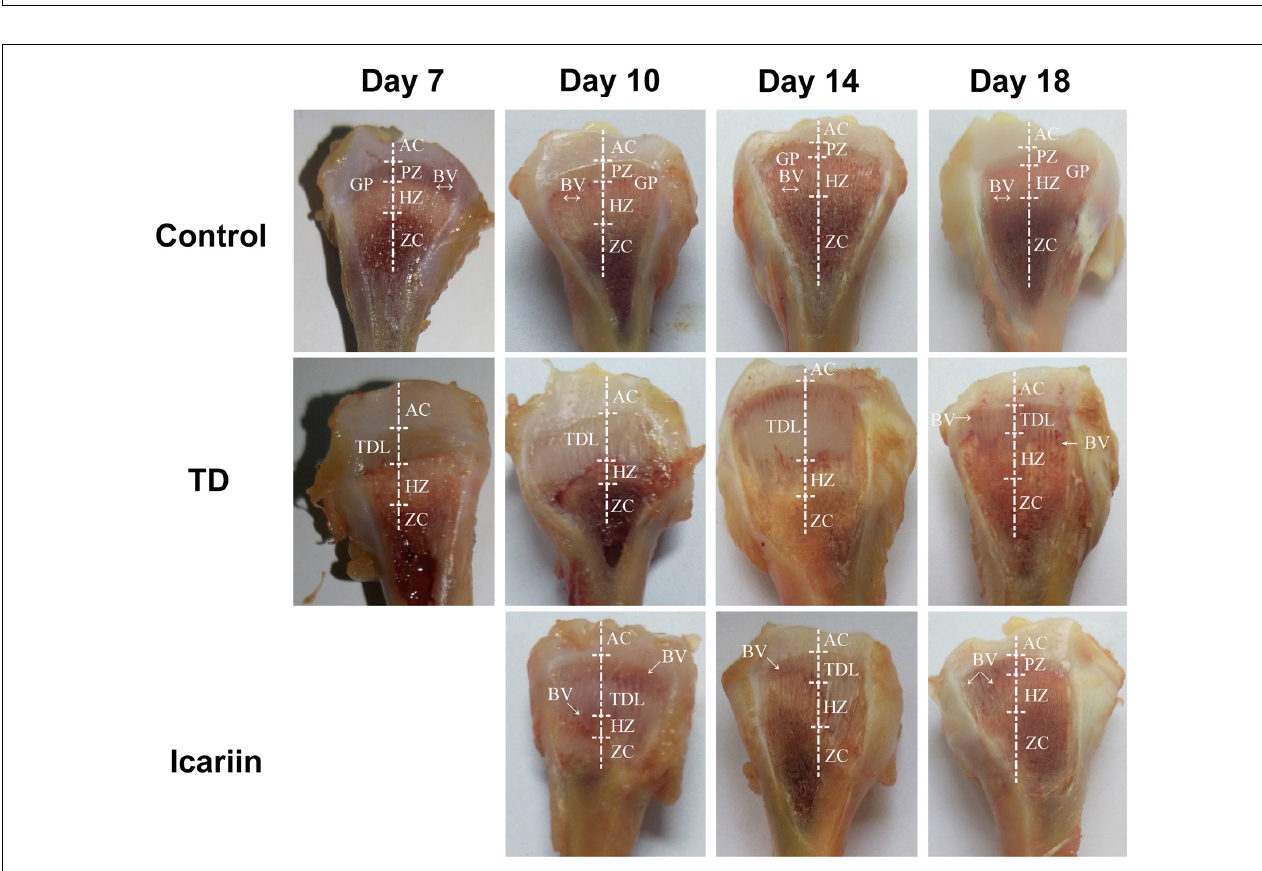
FIGURE 5 | The Morphological analysis of growth plates of control, TD, and icariin-treated chickens during the experiment from days 7 to 18. Extended GP was compared in TD group with control and icariin group. AC, articular cartilage; BV, blood vessel; GP, growth plate; PZ, proliferative zone; HZ, hypertrophic zone; TDL, tibial dyschondroplasia lesion; ZC, zone of